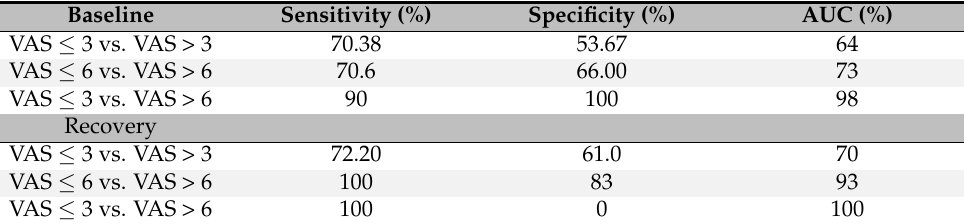
Table 2. Sensitivity, specificity, and the area under the receiver operating curve (AUC) at the baseline and